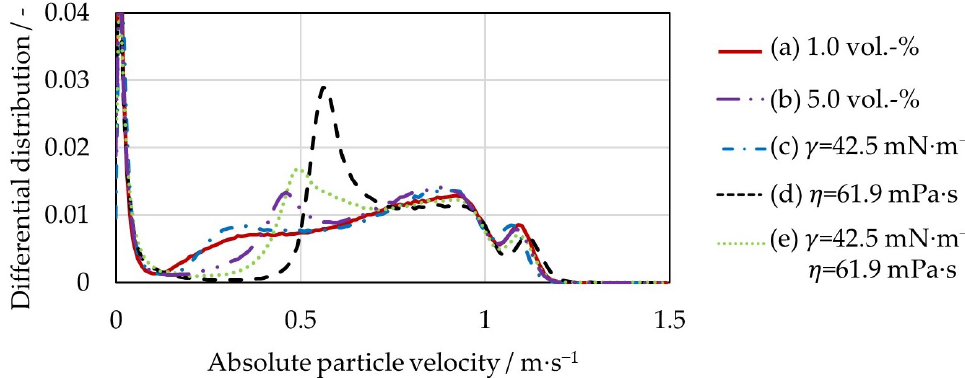
Figure 4. Differential distributions of the absolute particle velocity for a liquid loading of 1 vol.-%, a liquid loading of 5 vol.-%, a surface tension of 42.5 mN∙m − 1 , a viscosity of 61.9 mPa∙s, and a surface tension of 42.5 mN∙m −1 and a viscosity of 61.9 mPa∙s.